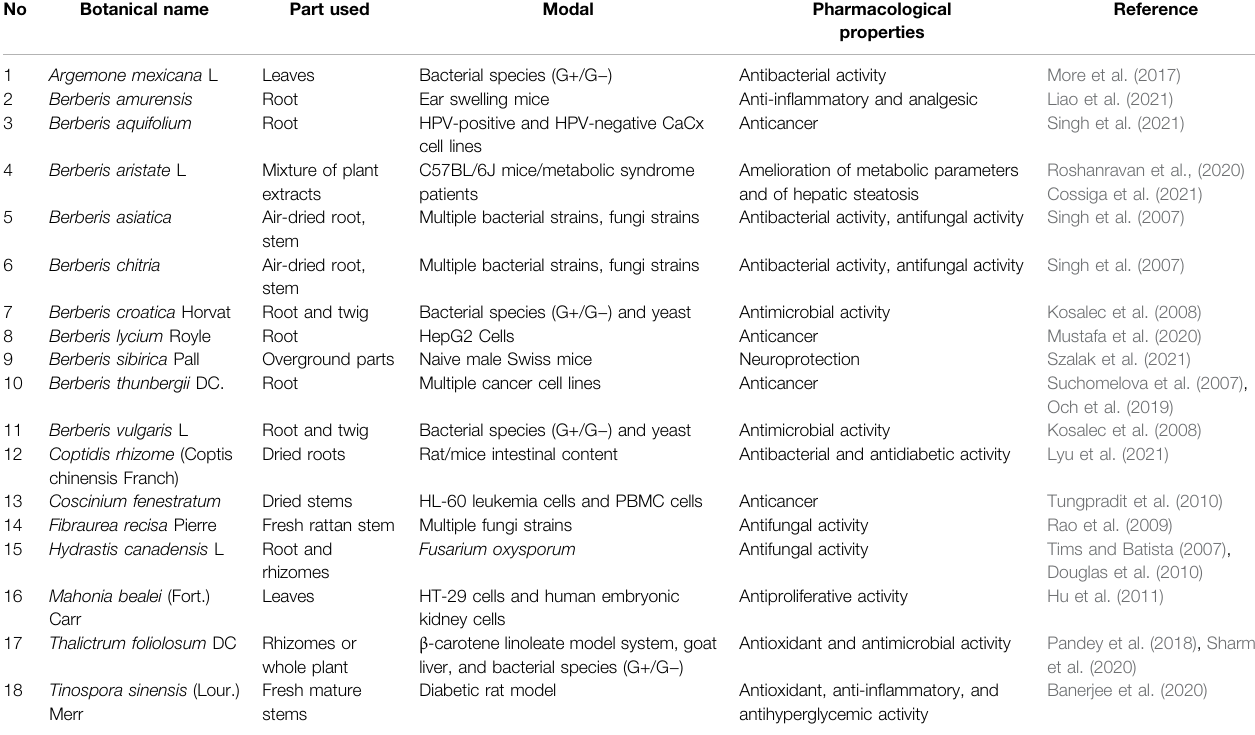
TABLE 1 | Representative examples of potential plant sources of berberine with medicinal value.